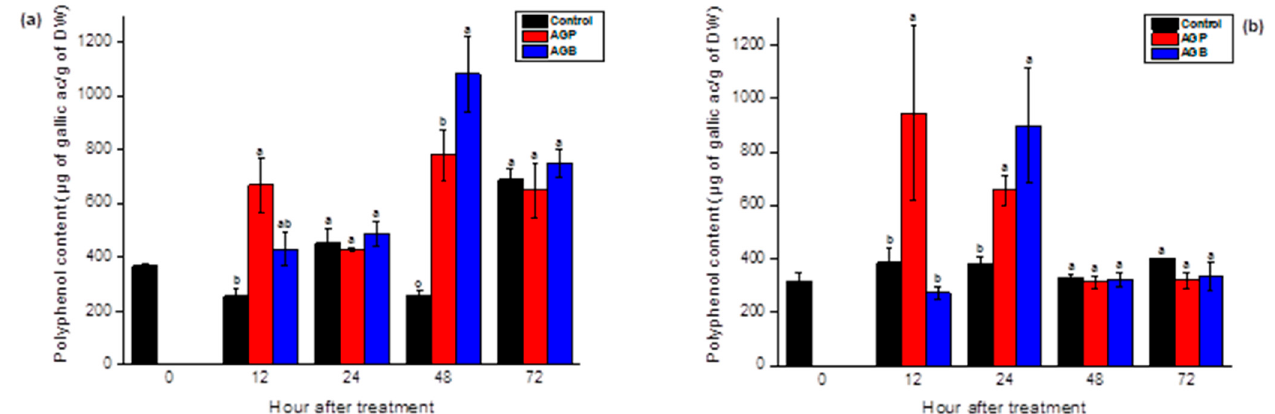
Figure 6. Accumulation of phenolic compounds in the leaves ( a ) and the roots ( b ) of tomato seedlings after injection (10 µ L) of AGB and AGP fractions (1 g/L). Each value is the mean of four repetitions ± SE. The letters (a, b, c) indicate significant differences between treatments (Control, AGB, and AGP) in each point time using the Tukey–HSD test, at ( p < 0.05). Treatments presented with the same letter are not significantly different.